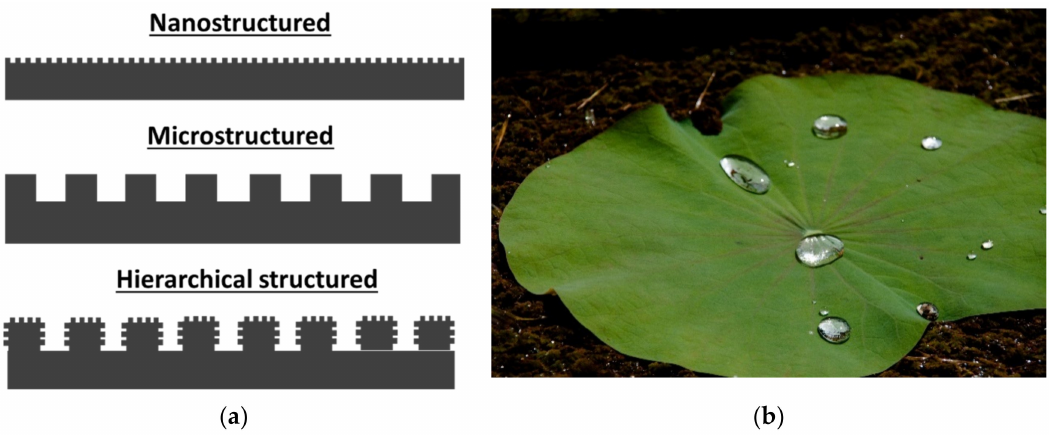
Figure 1. ( a ) Scheme of hierarchical textures formed by di ff erent levels of roughness. ( b ) Image of water repellency in the lotus